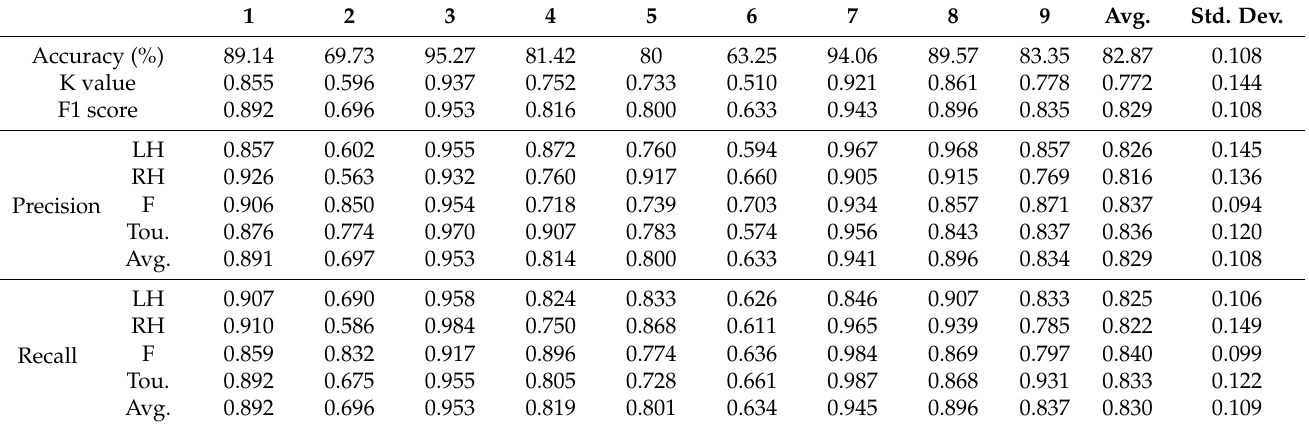
Table 3. Performance Metrics on the BCI-IV 2a dataset using the MBEEGSE.